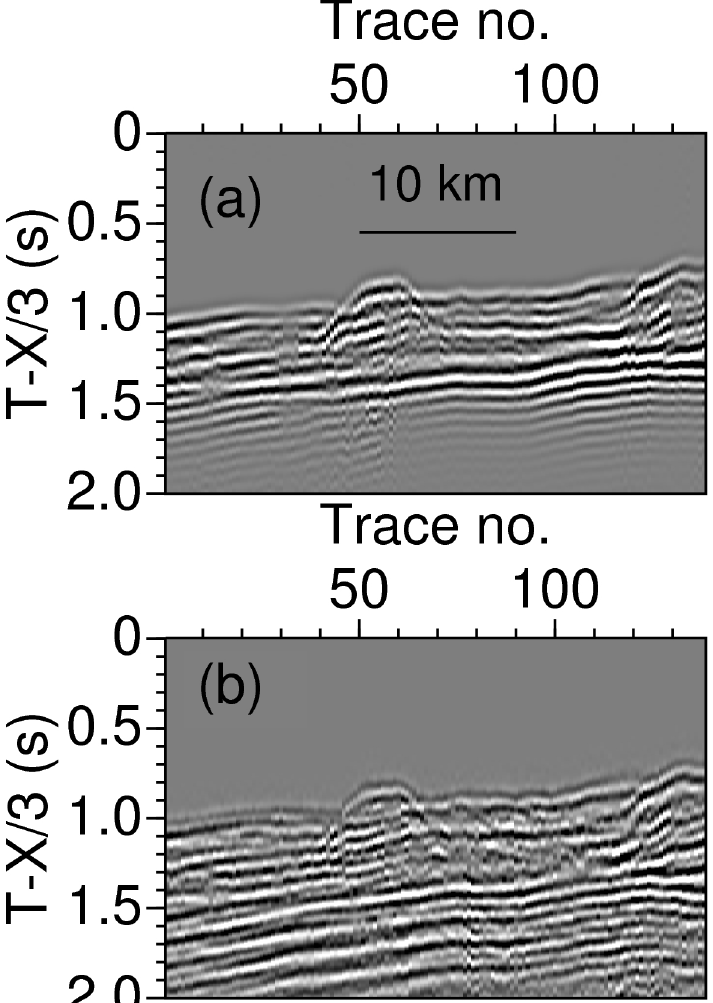
Figure 15. Common offset gather from ( a ) acoustic full waveform inversion data, and ( b ) observed data at offset 3308 m. The data is low pass filtered to 14 Hz. Trace spacing is 250 m